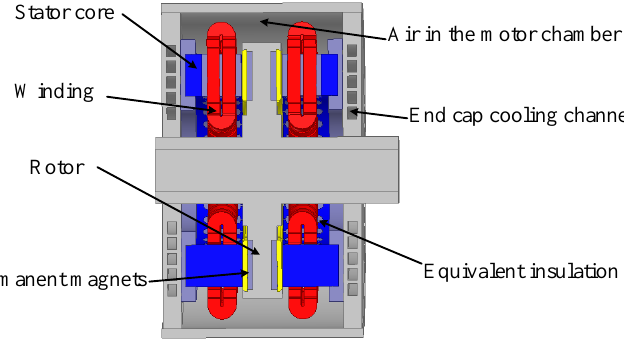
Figure 26. Motor temperature field solution domain model.